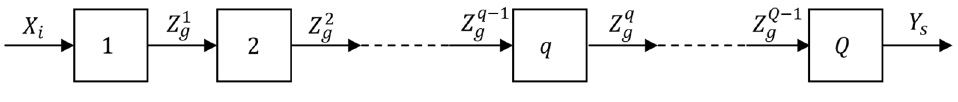
Figure 2. A series network structure.